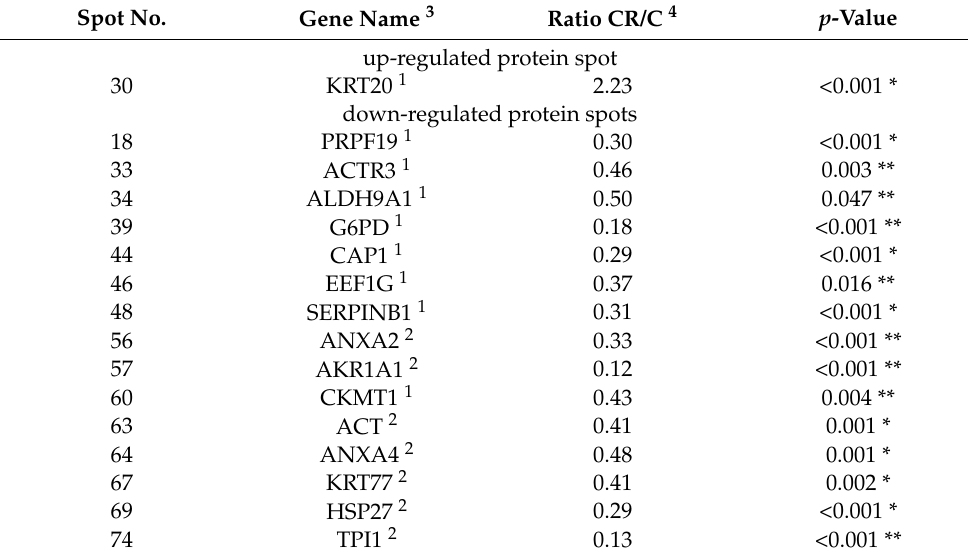
Table 5. List of the differentially expressed protein spots identified by MALDI-TOF MS and MALDI FT-ICR MS analysis found in the cecal mucosa of nursery pigs fed a diet enriched with 4% of dried chicory root. Spot numbers correspond to those in Figure 1. Spot No. Gene Name 3 Ratio CR/C